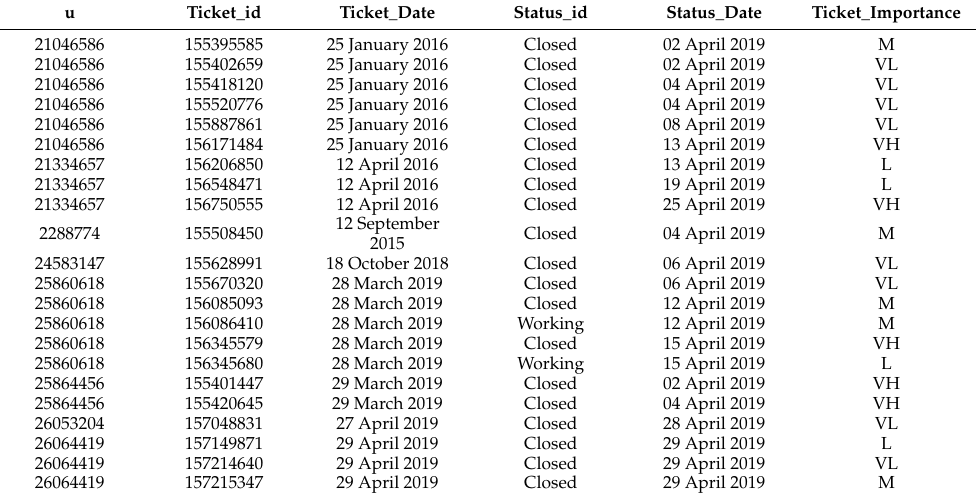
Table 5. Extract of T (cid:48) .